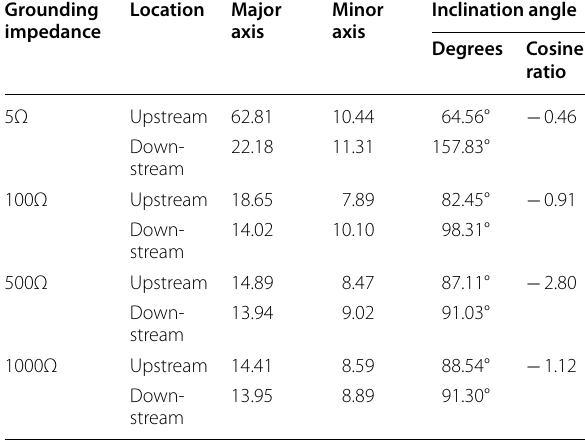
Table 5 Characteristic quantity of magnetic field ellipse Grounding impedance